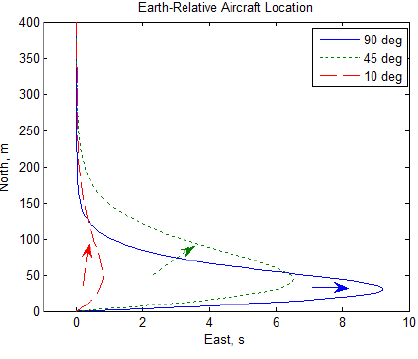
Figure 10: Position error reponse when using the No Wind Cor- rection Controller - NWCC